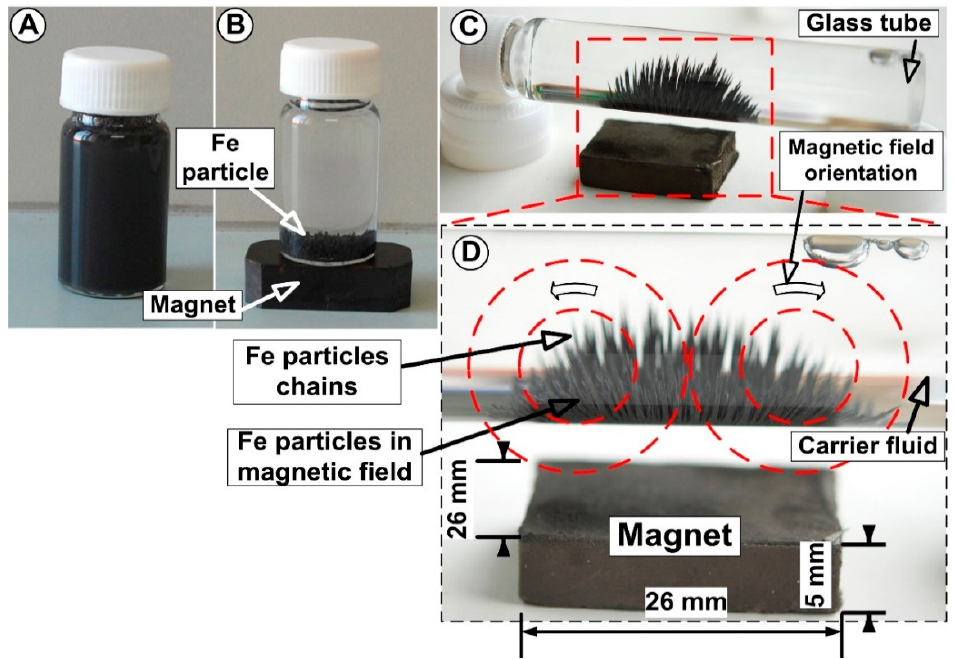
Figure 6. Ferromagnetic particle (FMP) separation in the presence of the magnetic field; ( A ) suspension in the absence of the magnetic field; ( B ) Fe particle separation in the presence of the magnetic field; ( C ) Fe particles contained in the model suspension forming chain structures aligning along the direction of the applied magnetic field. ( D ) Detail of the magnetic field orientation and and the ferromagnetic particle deposition along the magnetic Table 2. Rheological characterization of the carrier fluid and Fe particle suspensions.